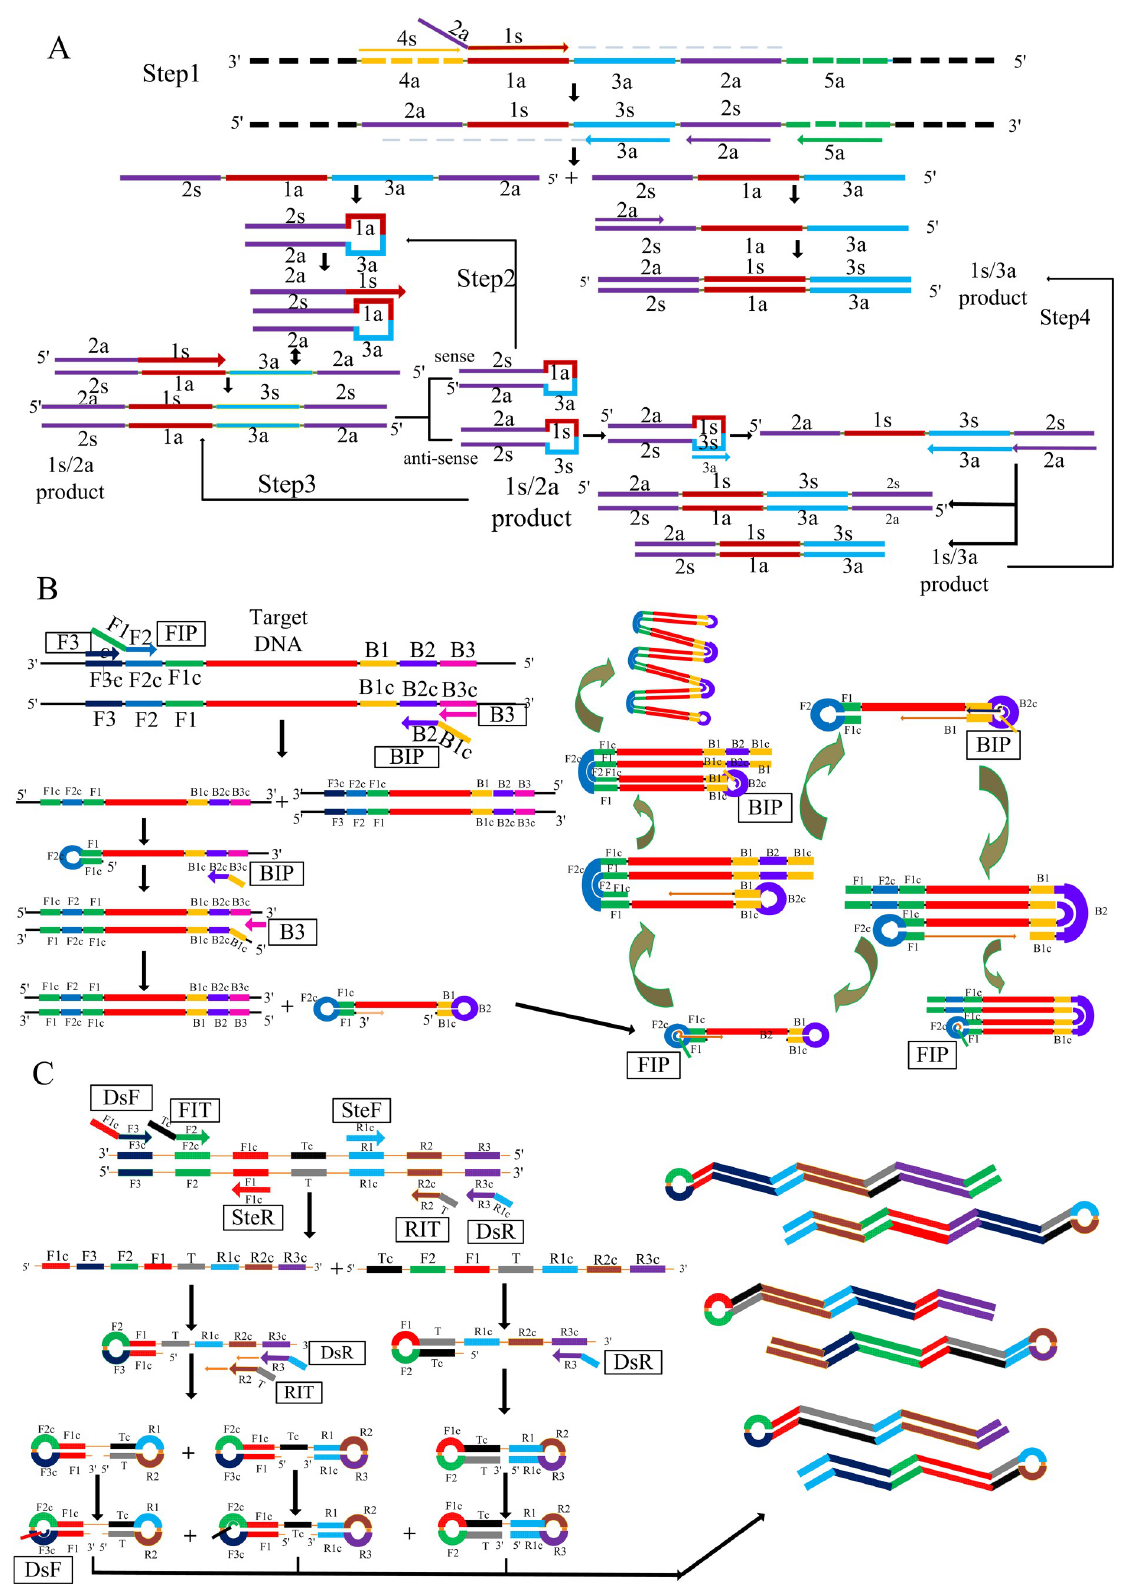
Fig 1. Schematic maps of CPA, LAMP and IMSA amplification reactions. A, Illustration of the CPA assay; B, Illustration of the LAMP assay; C, Illustration of the IMSA assay.